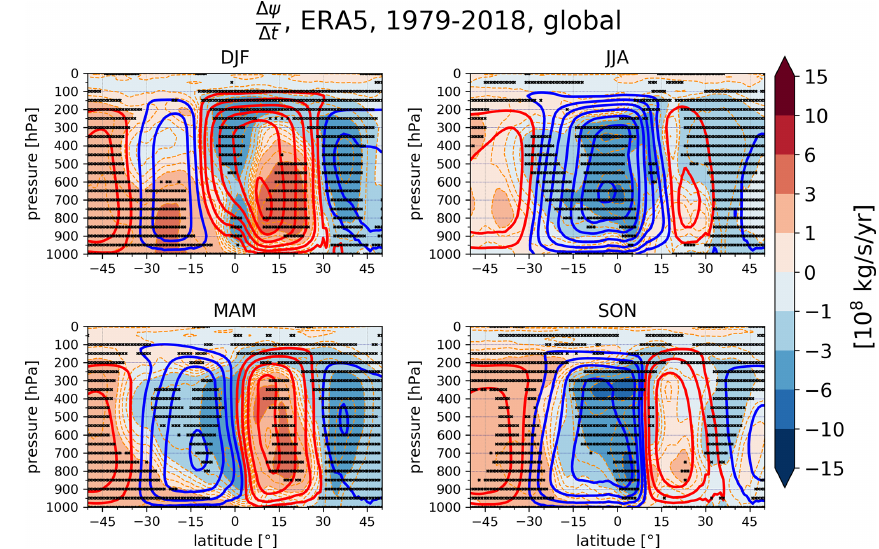
Figure 1. Seasonal-mean climatology of Hadley circulation (red and blue contours) and its trends (shading) in ERA5 reanalysis between 1979 and 2018. Red contours indicate positive climatological stream-function values, i.e. ( 0 . 1 , 0 . 3 , 0 . 6 , 1 , 1 . 5 , 2 , 2 . 5 ) × 10 11 kgs − 1 and blue contours their negative equivalents, i.e. ( − 0 . 1 , − 0 . 3 , − 0 . 6 , − 1 , − 1 . 5 , − 2 , − 2 . 5 ) × 10 11 kgs − 1 . Crosses indicate the statistically significant trends at the 95% confidence level. Note that the overlapping of contours and shading of the same colour indicates strengthening of the cell, while overlapping of different colours indicates cell